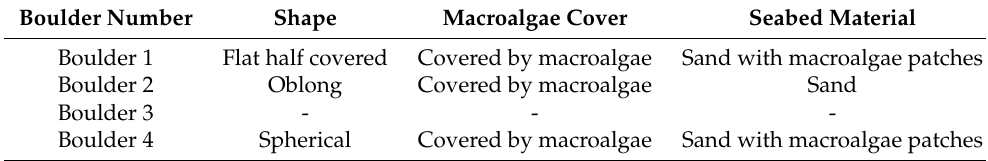
Table 10. Boulder overview.